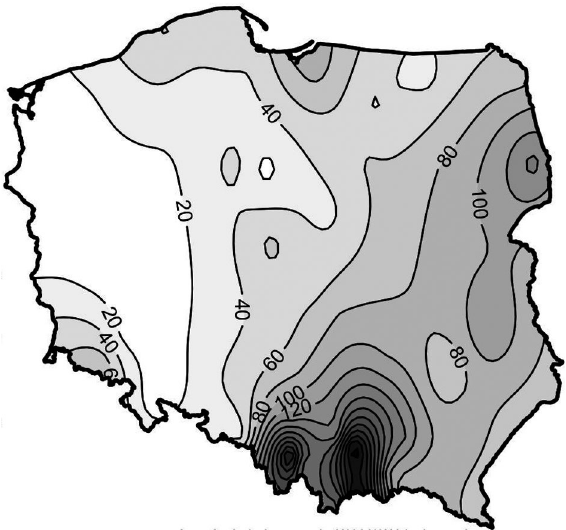
Fig. 7. Monthly MCP totals [mm] in Poland in August